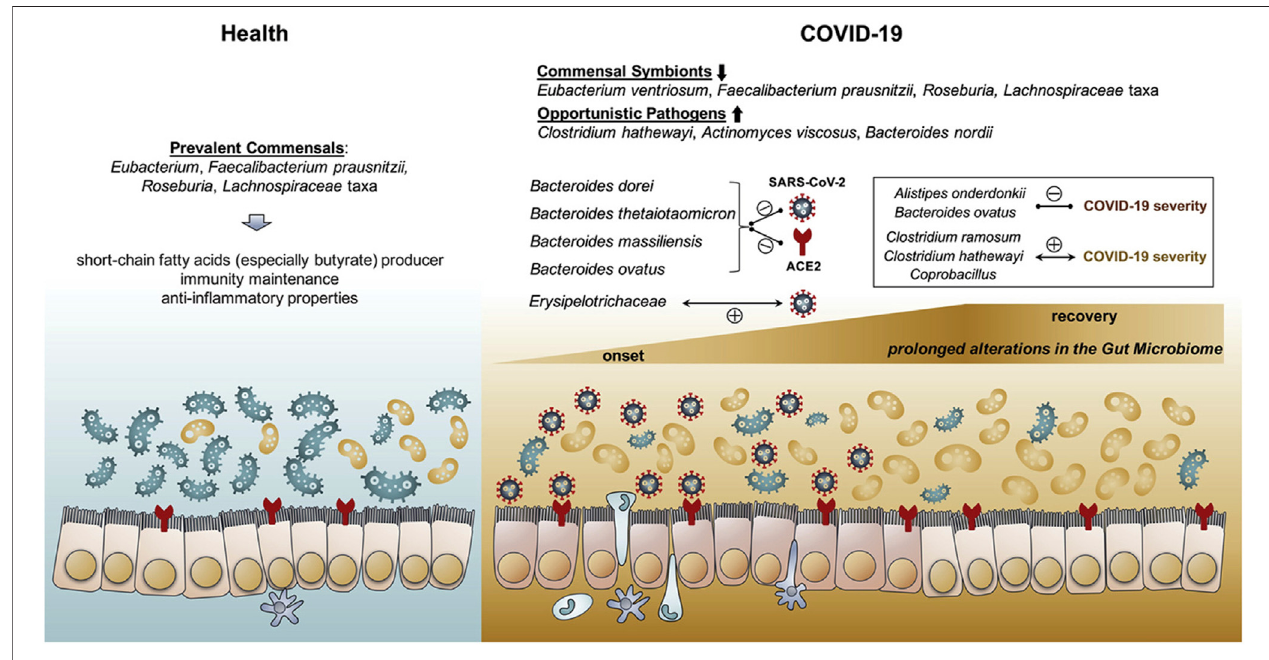
FIGURE3| SchematicsummaryofthegutmicrobiomealterationsinCOVID-19.A.Thegut fl orainhealthypeopleareenrichedwithshort-chainfattyacids(SCFAs) producingbacteria.WhileCOVID-19patientsarefrequentlyaccompaniedwithprolongedgutmicrobialdysbiosisduringandevenafterthediseasecourse,withelevated abundance of opportunistic pathogens and decreased abundance of bene fi cial commensals. Reproduced with permission (Zuo et al., 2020c). Copyright 2020, American Gastroenterological Association.